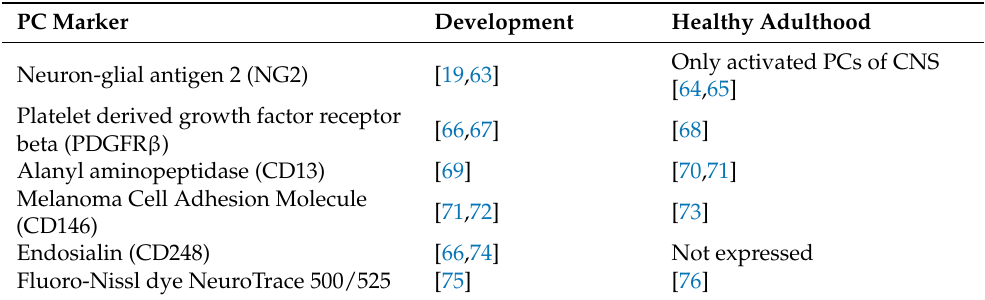
Table 1. BestknownmarkersofCNSPCsandtheirdynamicexpressionduringdevelopmentandadulthood. PC